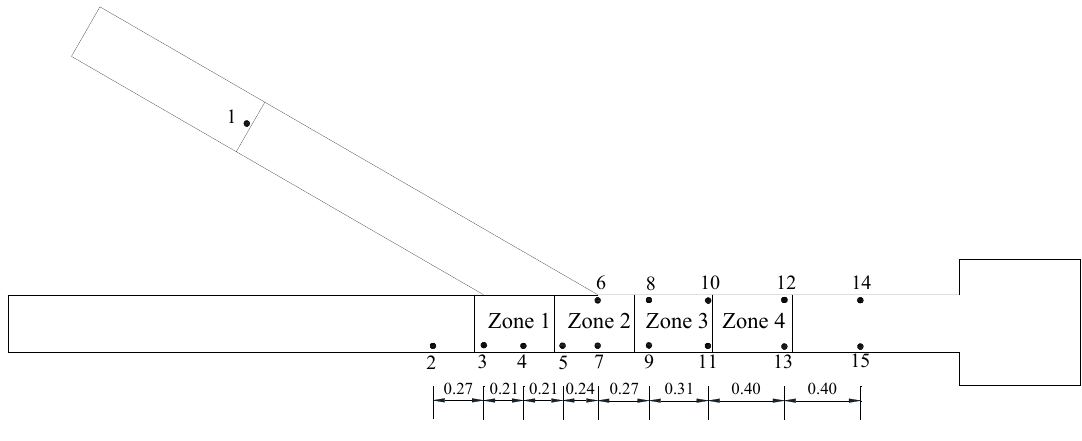
Figure 4. Layout of measuring points in the tests (unit: m).